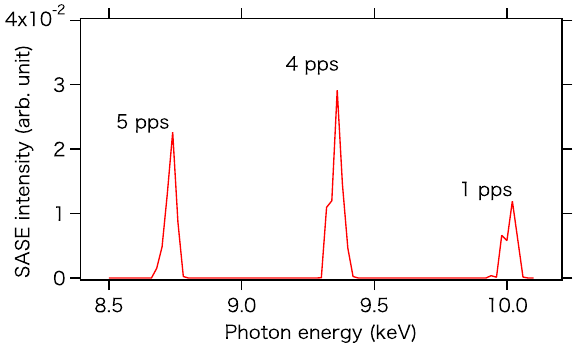
FIG. 6. Spectra of SASE measured by scanning a monochro- mator. The electron bunch repetition was 10 pps and the beam energy was changed between 7.3, 7.55, and 7.8 GeV.